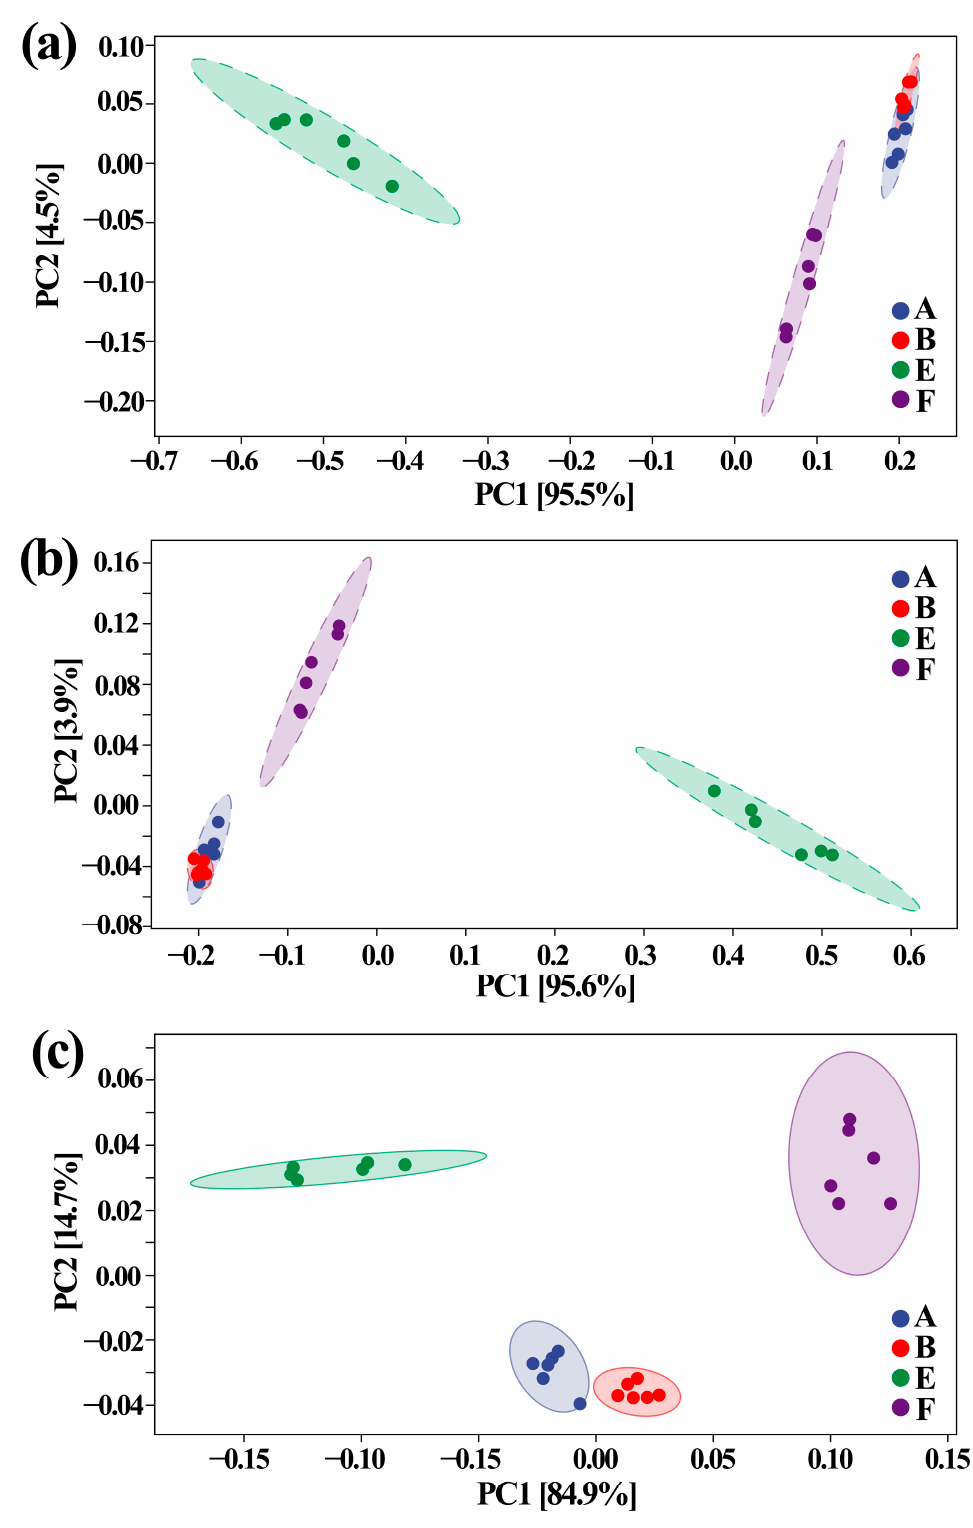
Figure 7. PCA of gut bacteria at levels of ( a ) phylum, ( b ) genus and ( c ) species. A: healthy children; B: healthy children + ZnONP; E: ASD children; F: ASD children + ZnONP. The comparison of this data with the greengene database indicated that the top 10 phylum of gut bacteria among the tested samples was Actinobacteria , Firmicutes , Proteobac-